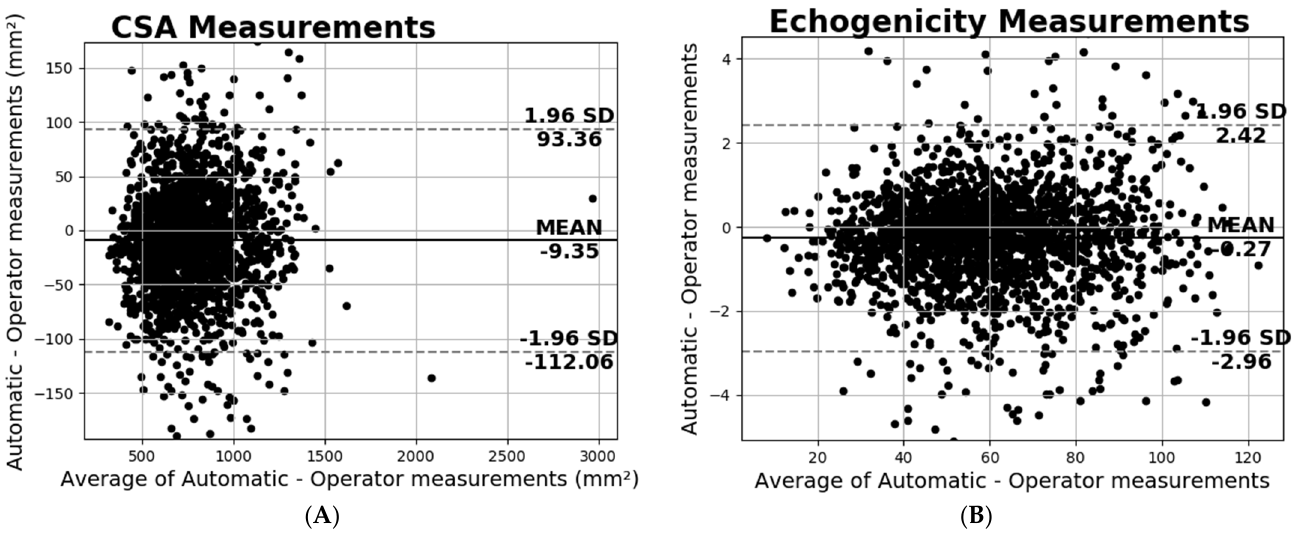
Figure 9. Bland − Altman plots of the ( A ) CSA and ( B ) echogenicity in all the databases.